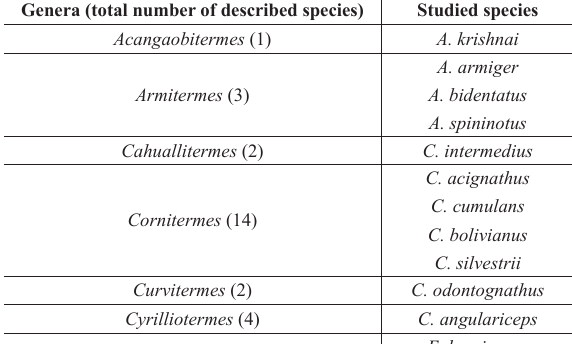
Table 1. Genera and species studied. Genera (total number of described